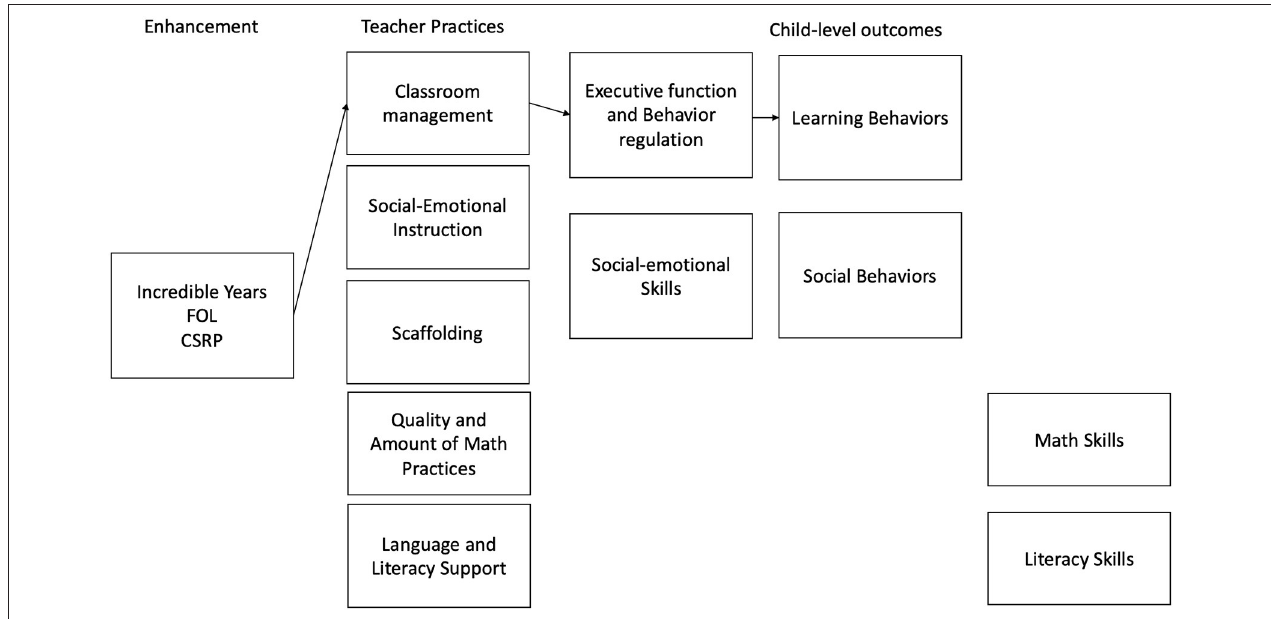
FIGURE 1 | Hypothesized theory of change for behavioral-focused